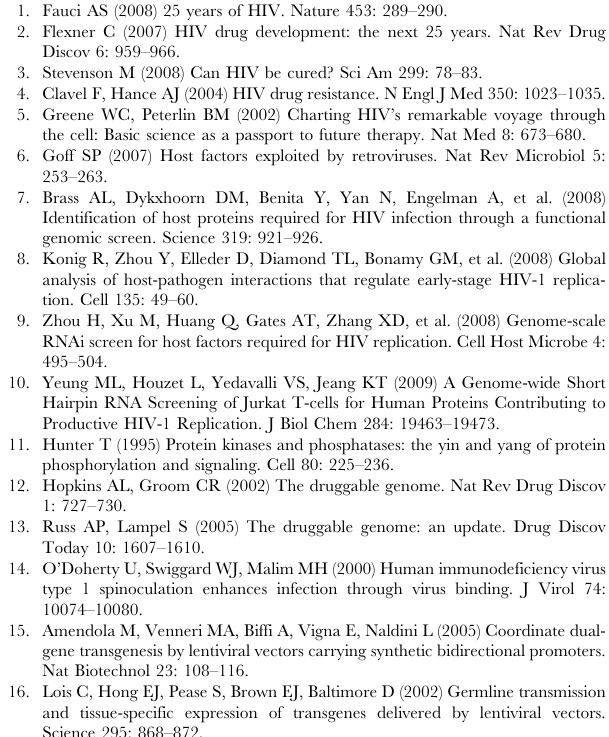
Figure S6 CD4 surface expression in Jurkat shRNA clones during HIV-1. Jurkat shRNA clones were infected with HIV- 1NL4-3 and CD4 positive cells were measured by flow cytometry at day 0, 2, 4 and 7. Dash lines indicate the values for shSCRAM clone. Values represent mean 6 SEM (n =3). Table S1 shRNA sequences used for each gene in study. For each gene three to five shRNA sequences were cloned in pLK01 for knockdown of gene expression.